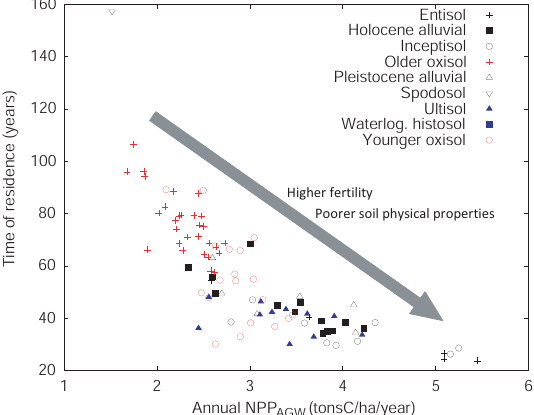
Fig. 8. Time of residence of carbon in wood plotted versus NPP AGW (ground measurements from Malhi et al., 2004), for forest stands grouped according to their soil type. The arrow represents an interpretation based on Quesada et al.